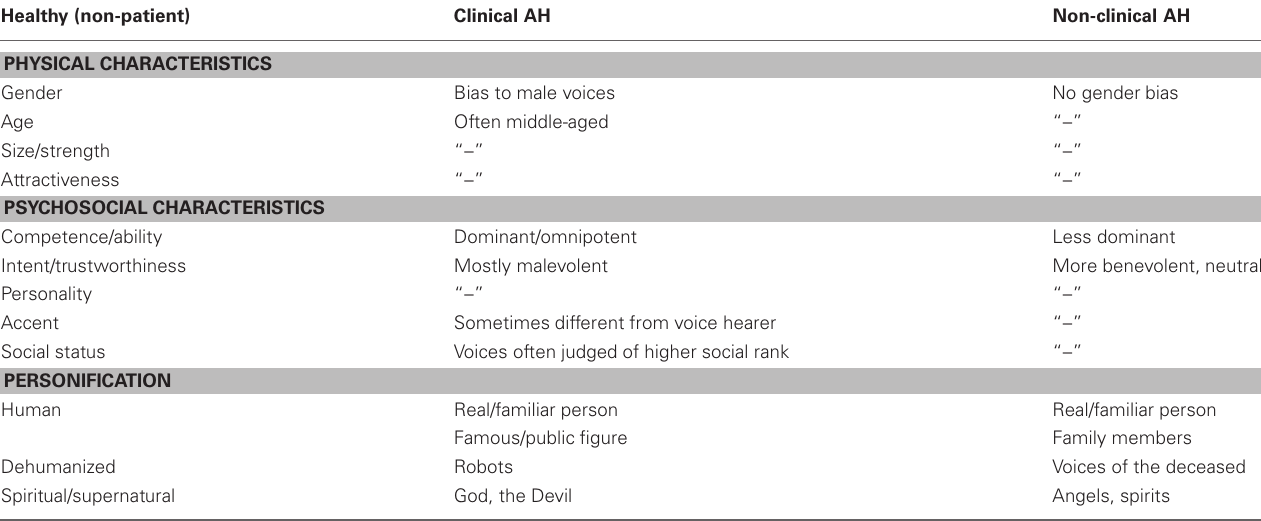
Table 1 | Features of voice identity perceived in real and hallucinated